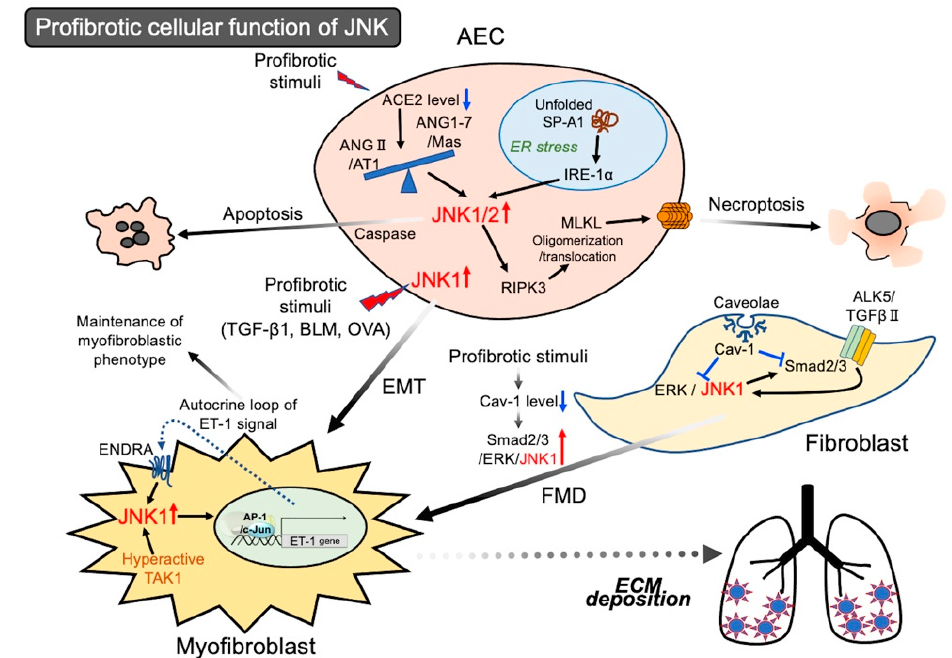
Figure 2. The molecular mechanism of JNK-mediated pulmonary fibrosis. JNK participates in various cellular responses to profibrotic stimuli: apoptosis, necroptosis, and EMT of alveolar epithelial cells (AEC); FMD of fibroblasts; and maintenance of the myofibroblastic phenotype.